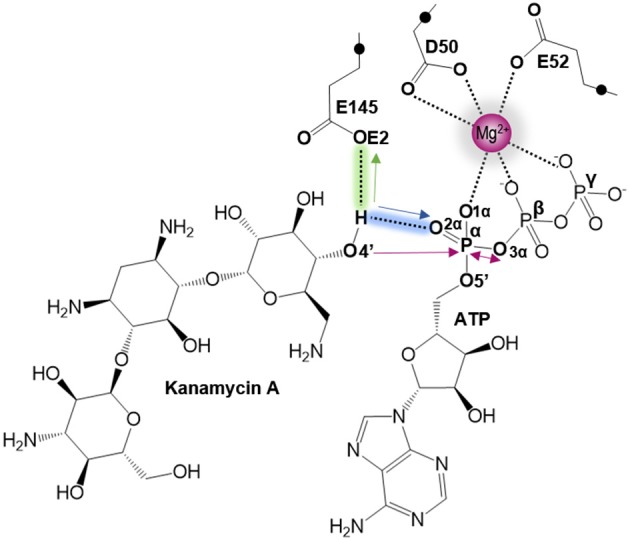
Schematic representation of the two proposed mechanisms of KAN inactivation by ANT(4'). The blue and green arrows represent the two different paths of O4′ activation by ATP (for ATP-assisted) and by Glu145 (for Glu145-assisted mechanism), respectively. Pink arrows indicate common process for both proposed mechanism of nucleophilic attack of O4′ to Pα and Pα–mO3α bond cleavage.